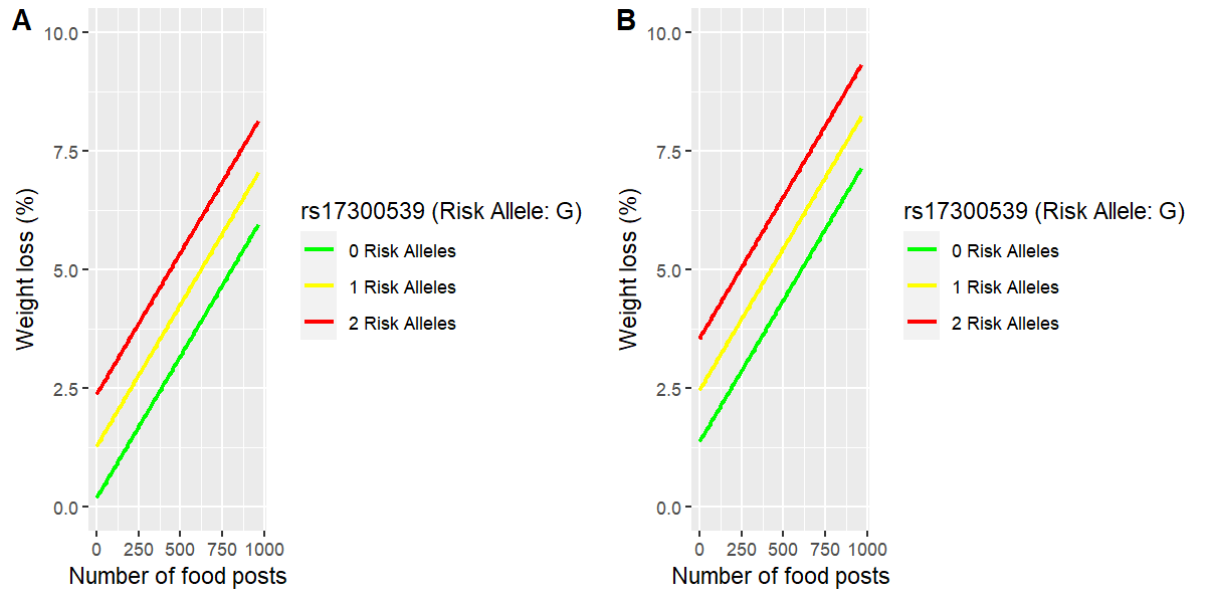
Figure 2. Weight loss (%) versus food posts by rs17300539 (monounsaturated fat intake and weight gain tendency single-nucleotide polymorphism) in females (A) compared with males